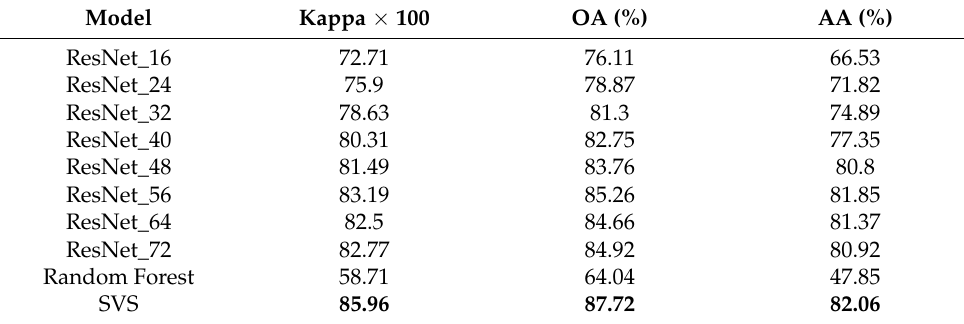
Figure 7. The identification accuracy of Random Forest, ResNet, and SVS, for each LCZ type. Here, different patch sizes were tested to check whether patch size matters to traditional scene classifier, e.g., ResNet_16 means the model uses a 16 × 16 patch size. Table 3. The overall accuracy of different